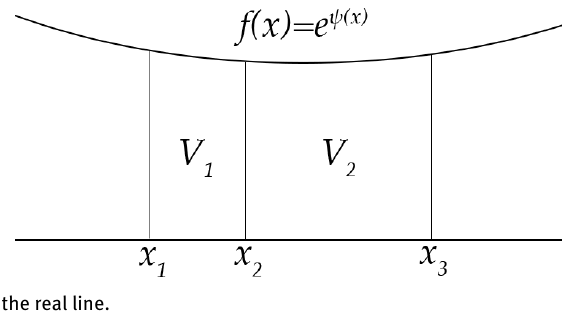
Figure 6: A double interval on the real line.